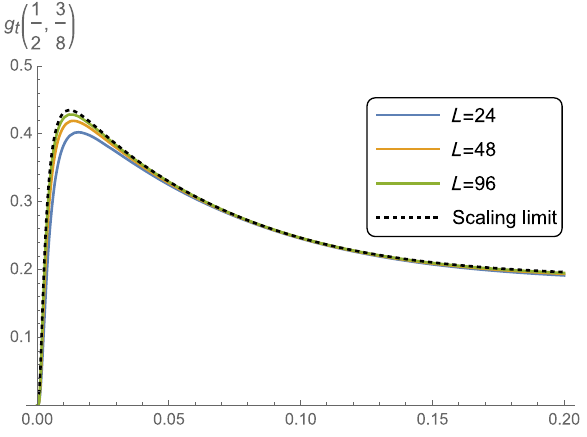
FIG. 4. Boundary conditions that fit the initial domain wall 1 , n 0 ). state ( n a ¼ b ¼